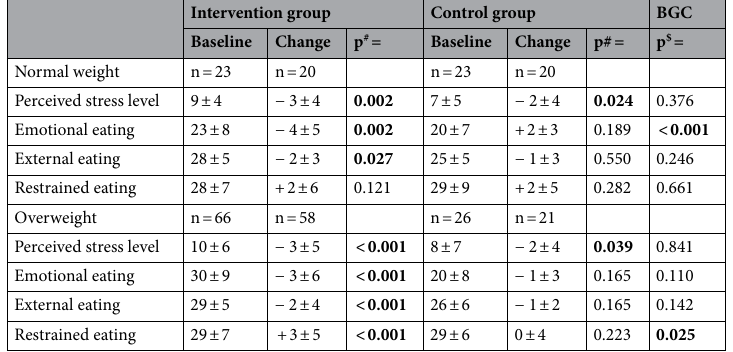
Table 3. Change of perceived stress and stress-related eating behaviour after 8 weeks in participants with normal weight and overweight of the intervention and control group. Significant values are in bold. Normal weight (BMI < 25 kg/m 2 ); Overweight (≥ 25 kg/m 2 ); w = week; p # = within group p-value; p $ = between group p-value; BGC between group comparison.